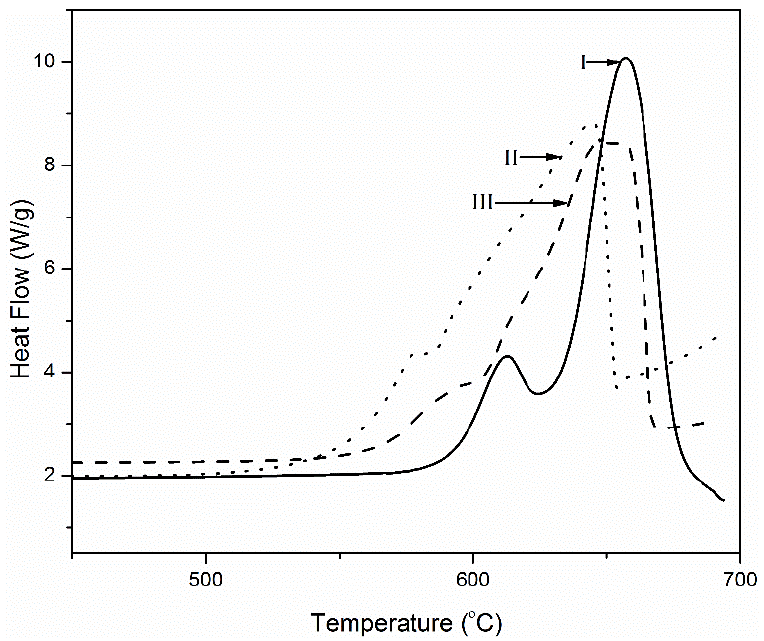
Figure 8. DSC thermograms obtained in air (I) Neat polyimide, (II) Polyimide-50 wt.% grapheme, (III) Polyimide-30 wt.% graphene ( β = 10 °C/min) .